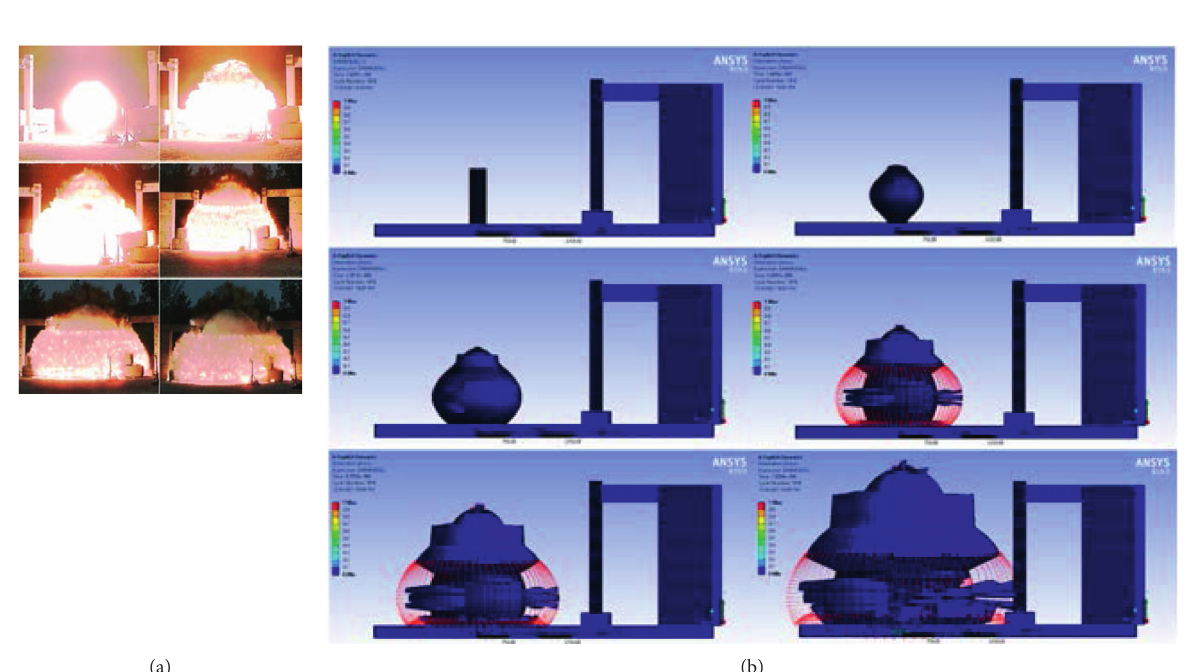
Figure 6: Blast wave propagation: (a) field test carried out by Siba [20]; (b) FEA